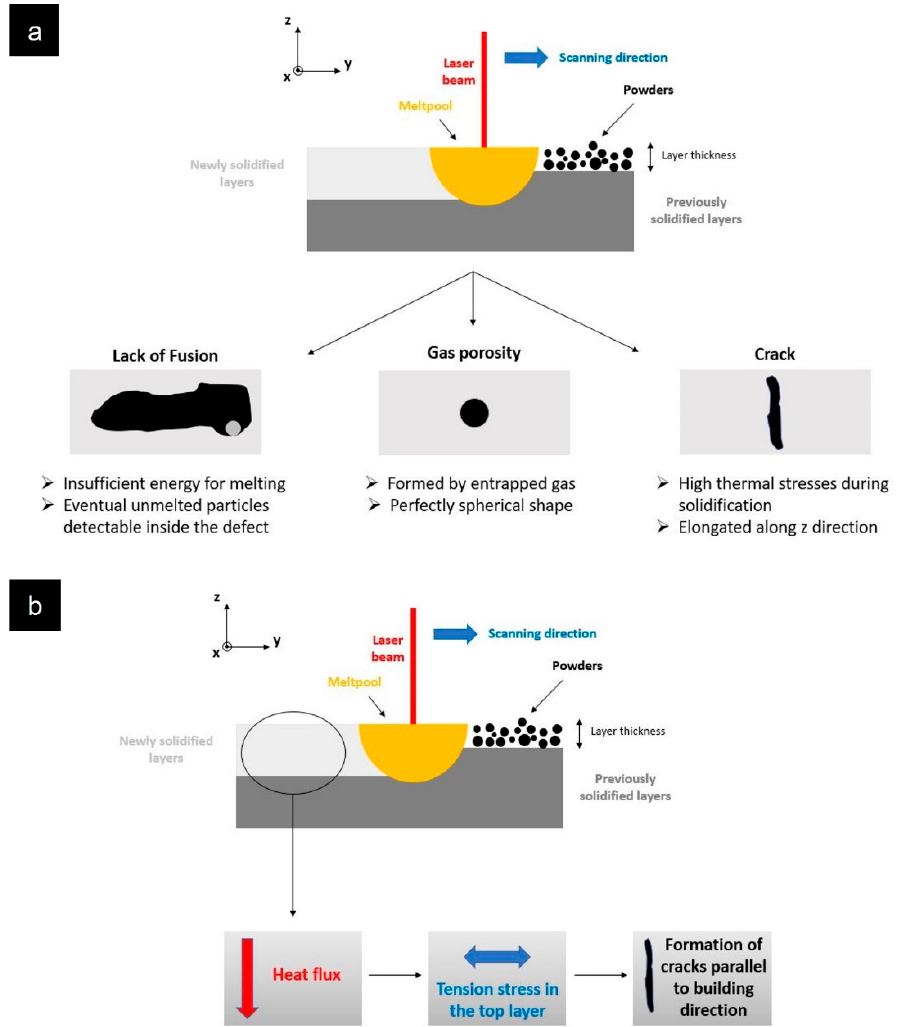
Figure 15. Representation of ( a ) the different typical defects formed by the L-PBF process and ( b ) the causes of the formation of cracks parallel to the building direction.